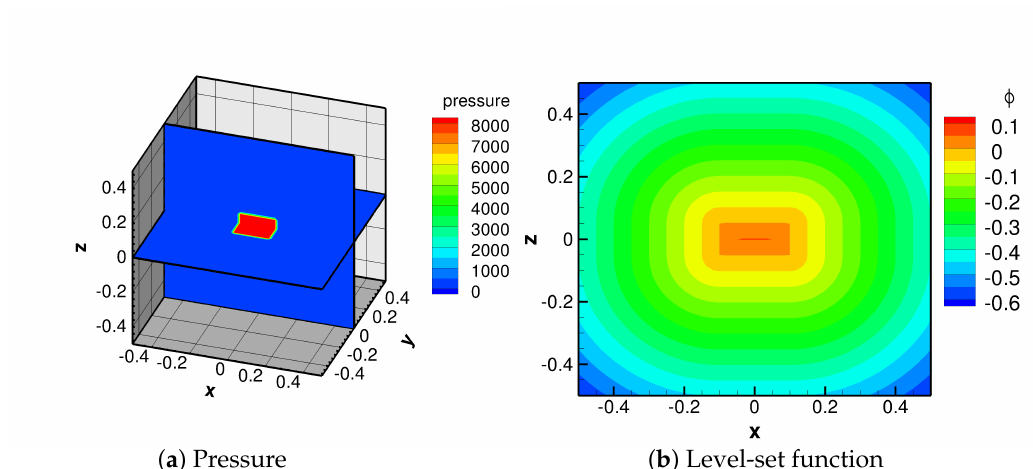
Figure 7. The initial setup of the UNDEX simulation with a high-pressure gas bubble in a cuboidal shape. The configurations of the figure are similar to Figure